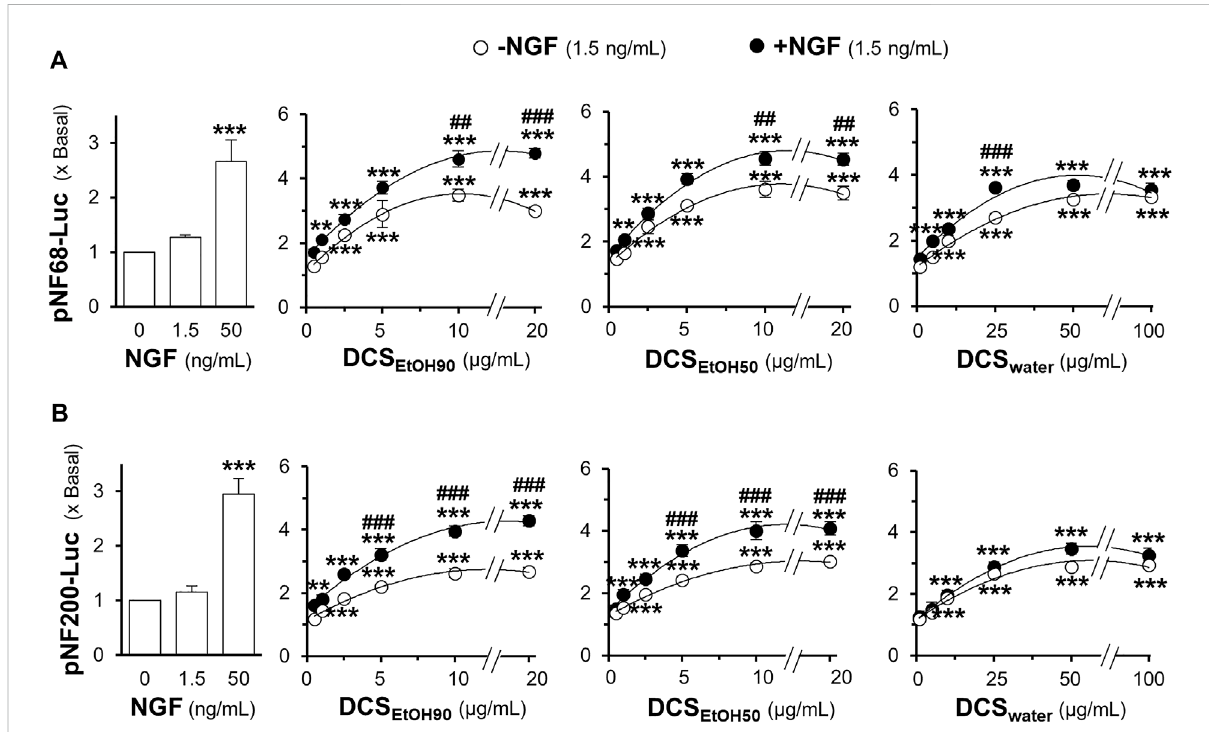
FIGURE 7 D. cochinchinensis stemwood extracts stimulate the transcriptional regulation of neuro fi lament promoters. Cultured PC12 cells transfected with the neuro fi lament promotor constructs pNF68-Luc and pNF200-Luc were treated with DCS EtOH90 , DCS EtOH50 , or DCS water alone or in conjugation with 1.5 ng/ml NGF for 24 h. Cell lysates were collected for determining luciferase activity of (A) pNF68-Luc and (B) pNF200-Luc transfected cells. The luciferase activity is normalized to the amount of protein and represented as fold change, where mean ± SEM for n = 4. ** p < 0.01 and *** p < 0.001 as compared to untreated cells. ## p < 0.01 and ### p < 0.001 as compared to cells treated with the extracts in the absence of 1.5 ng/ml